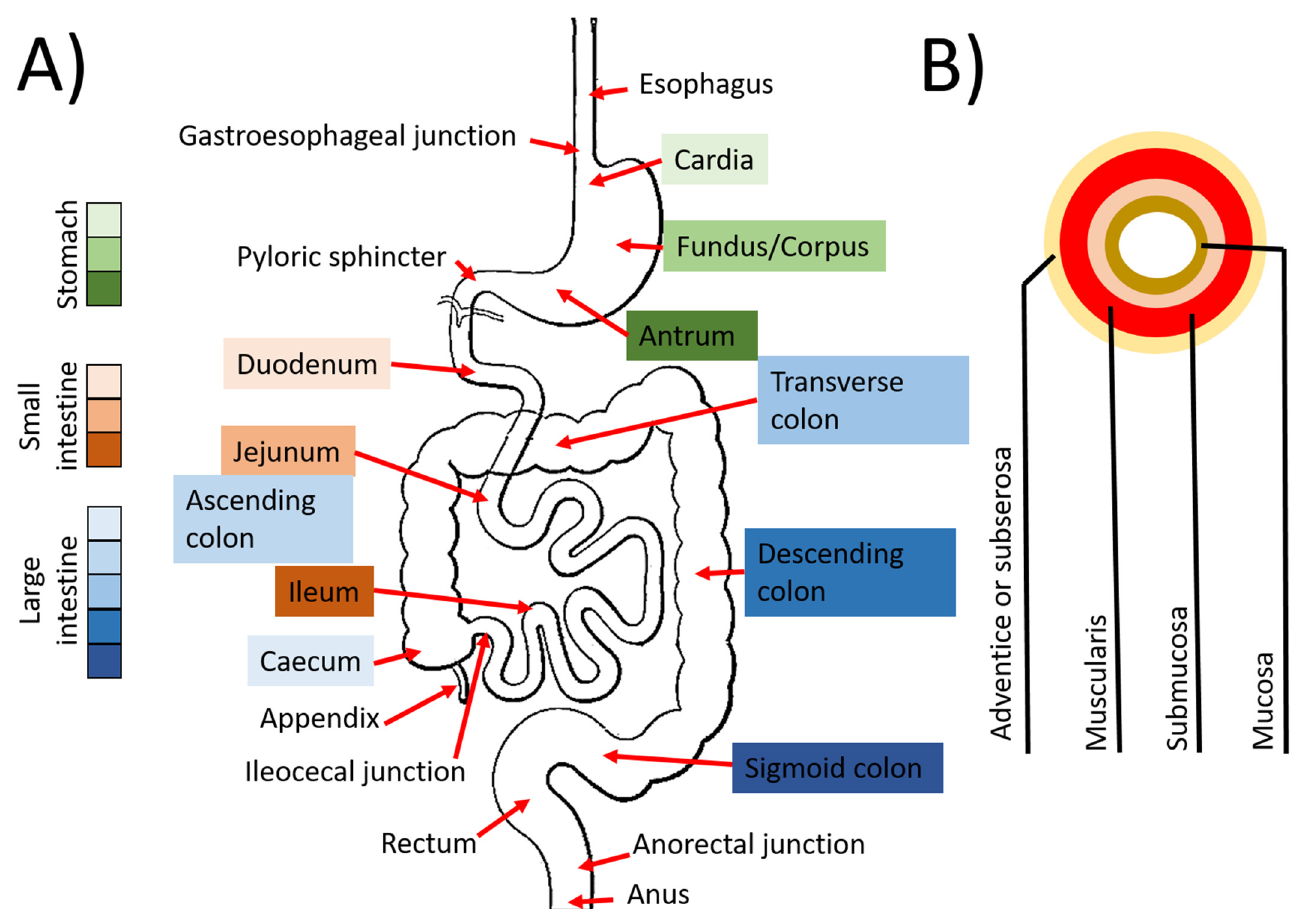
Figure 3. Schema of the digestive tract. ( A ) Gross anatomy of the digestive tract with the different regions. ( B ) Schema of the organization of the tissue. Some regions can vary in width or organization, but the general schema remains roughly the same.